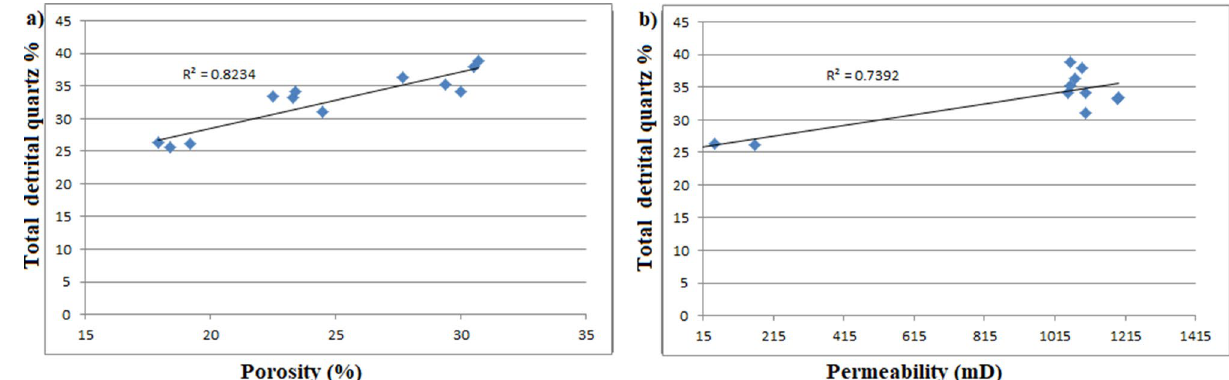
Figure 17. Cross-plot showing the relationship between detrital quartz content and porosity and permeability. The higher the detrital quartz content, the greater the porosity and permeability.